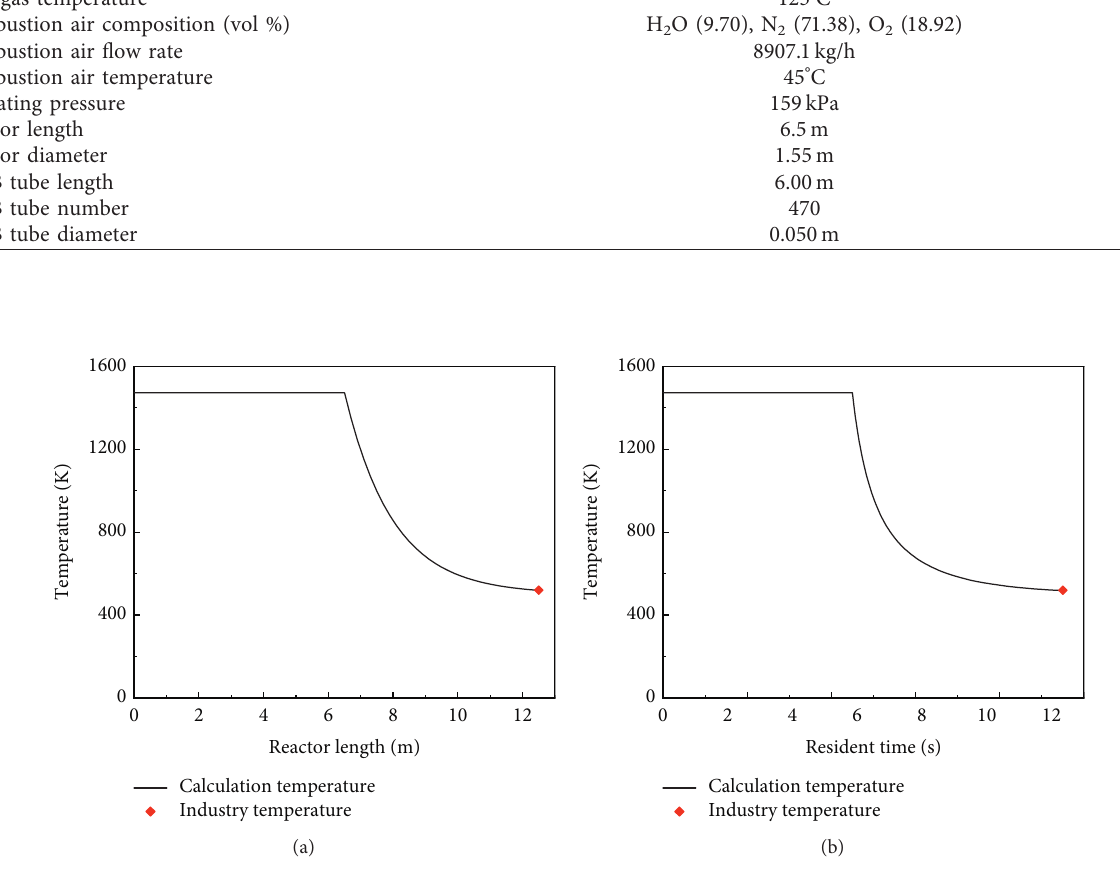
Figure 4: Temperature (K) profile in the TR and WHB.